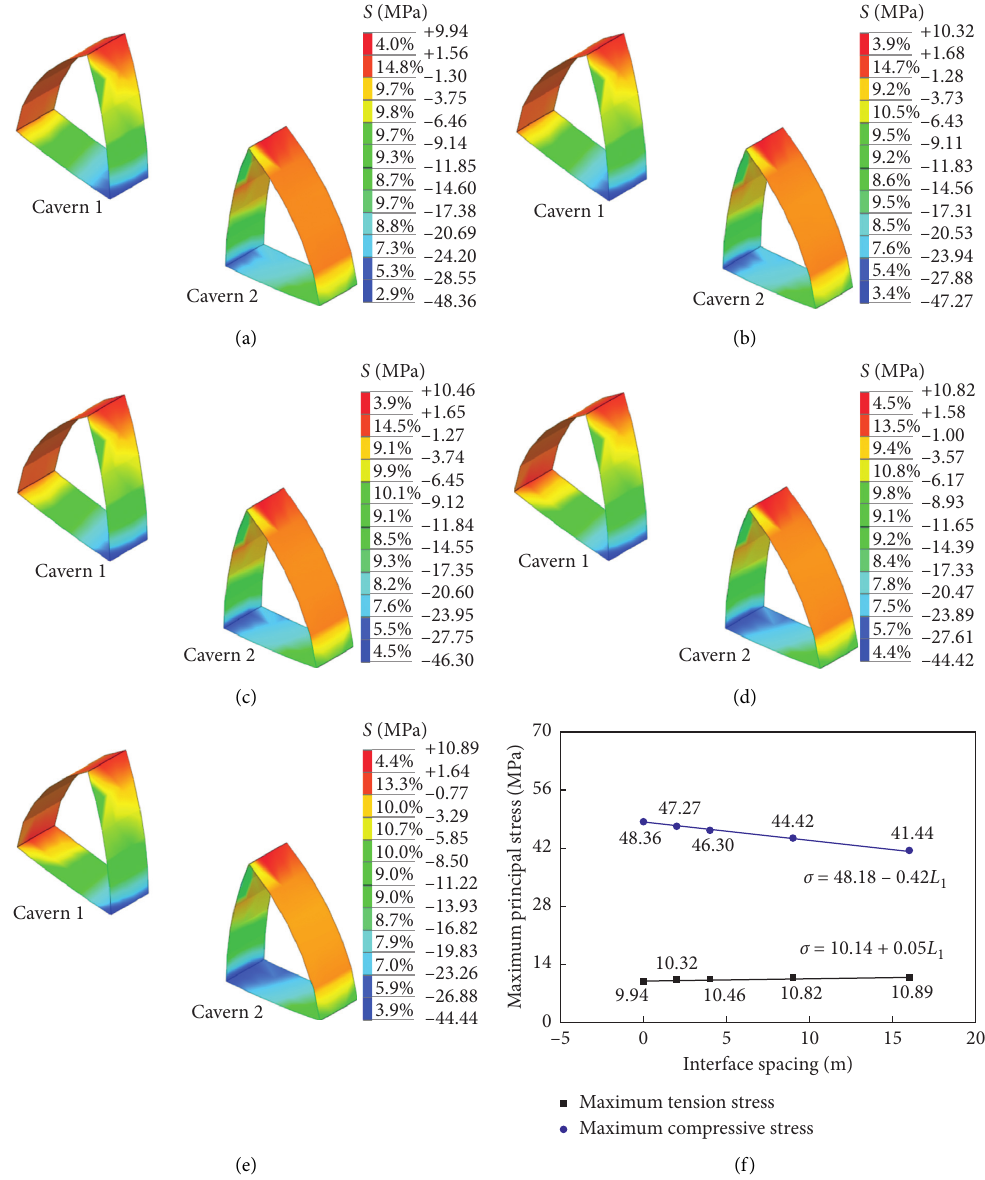
Figure 6: Distribution characteristics of principal stress of supporting structure. (a) L (e) L 1 � 16m. (f) Relationship between maximum principal stress and excavation face distance ( L 1